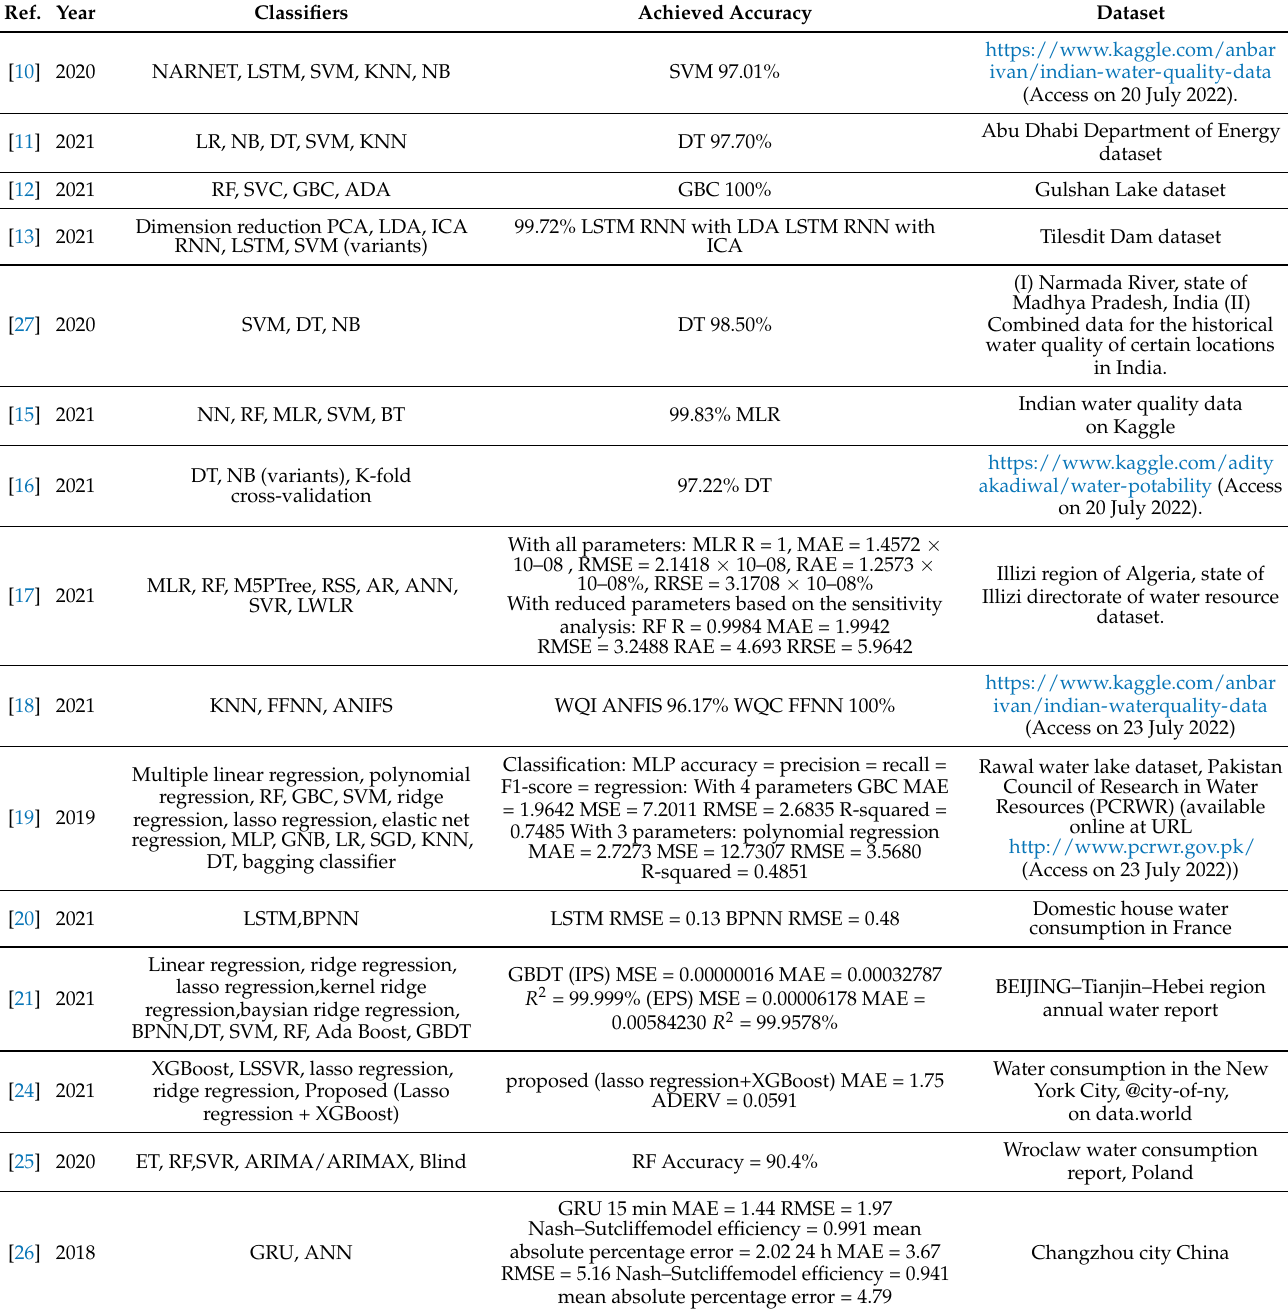
Table 1. Comparative summary of the discussed research works.